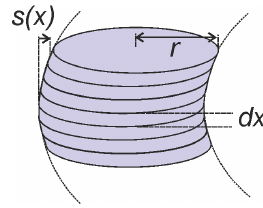
Figure 8. The model of the column deformation under the action of inertial lateral forces. Each slice has a circular